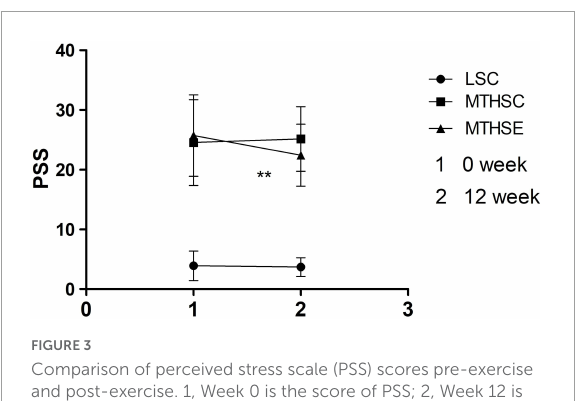
FIGURE3 Comparison of perceived stress scale (PSS) scores pre-exercise and post-exercise. 1, Week 0 is the score of PSS; 2, Week 12 is the score of PSS; PSS, self-assessed stress scale; ** p < 0.01 , compared with